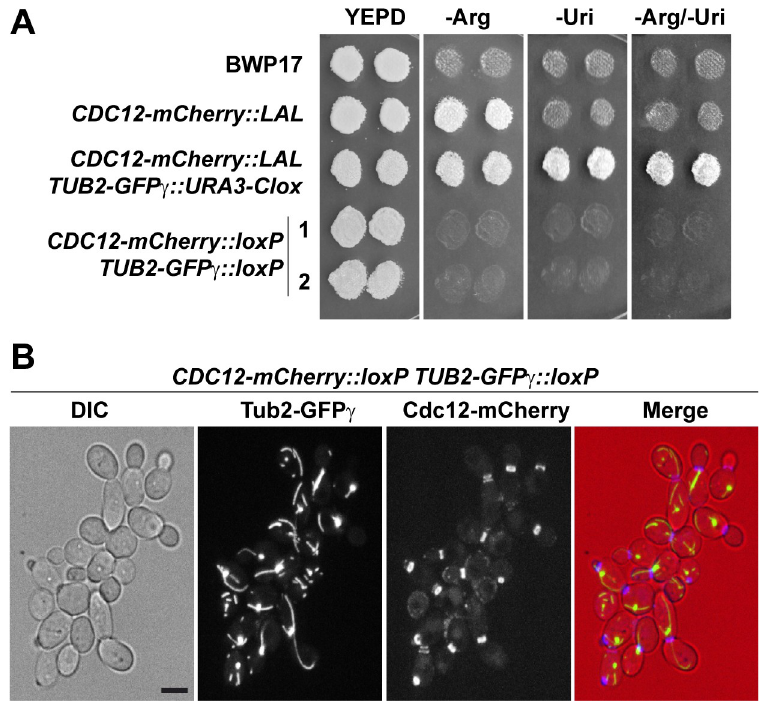
Fig 4. Double fluorescent tagging with GFP γ and mCherry. (A) Growth in selective media. Single colonies of strains BWP-17, CDC12-mCherry :: LAL , CDC12-mCherry :: LAL TUB2-GFP γ :: URA3-Clox and two independent clones of the resolved strain CDC12-mCherry :: loxP TUB2-GFP γ :: loxP (1 and 2) were grown on YPD plates and replica-printed to SC -Arg, SC -Uri or SC -Arg/-Uri media. (B) Localization of Cdc12-mCherry and Tub2-GFP γ during yeast growth. Exponential growing cultures of the CDC12-mCherry :: loxP TUB2-GFP γ :: loxP strain were imaged. The images are the maximum projection of 5 planes and show the differential interference contrast image (DIC), the Tub2-GFP γ and the Cdc12-mCherry channels, and the merged image (DIC in red, Tub2-GFP γ in green and Cdc12-mCherry in blue). Scale bar, 2 μ